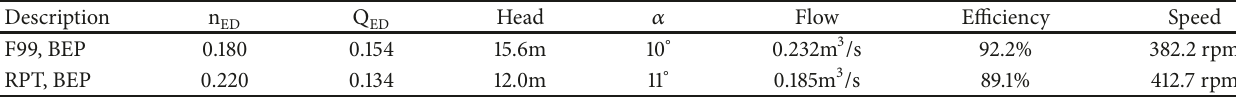
Table 1: Measurement summary. 𝛼 is guide vane opening as defined in the IEC60193 [11].